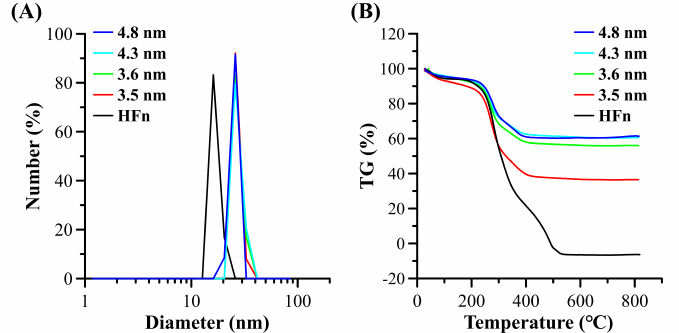
Figure 4. Dynamic light scattering ( A ) and Thermogravimetry ( B ) characterization of MHFn nanoparticles.